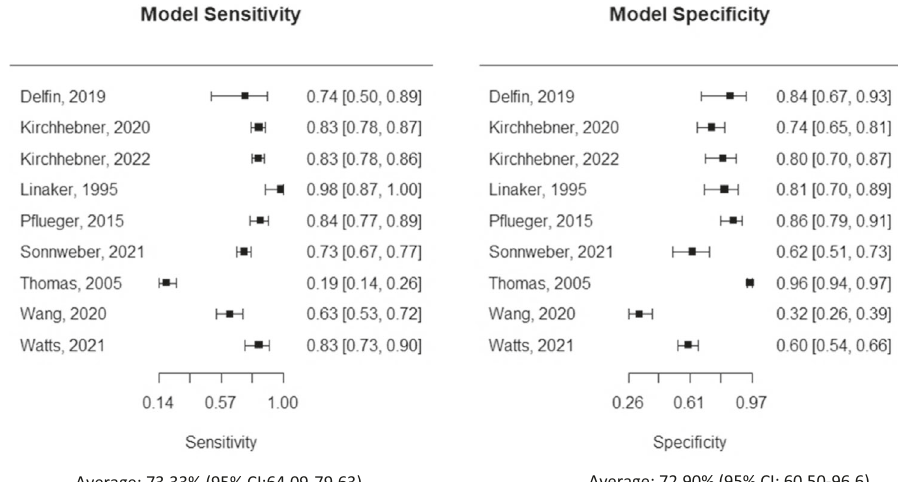
Average: 73.33% (95% CI:64.09-79.63) Average: 72.90% (95% CI: 60.50-96.6) Fig. 1 Paired Forest plot of model accuracy for criminal and violent outcomes in psychiatry. A linear mixed model with random effects was selected to produce summary estimates of sensitivity and speci fi city using the retisma function in mada. The average sensitivity across studies was 73.33% (95% I: 64.09 – 79.63) and average speci fi city was 72.90% (95% CI: 60.50 – 96.6). As such, the balanced accuracy across models (sensitivity + speci fi city/2) is